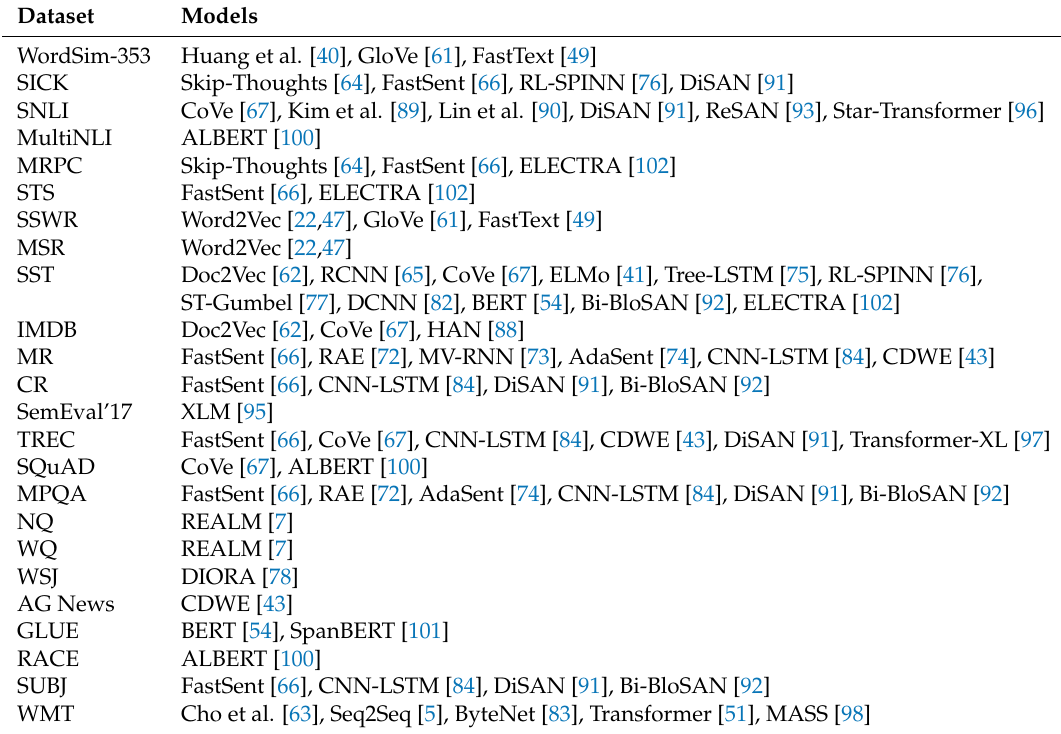
Table A1. Datasets used for evaluation of models we referenced in